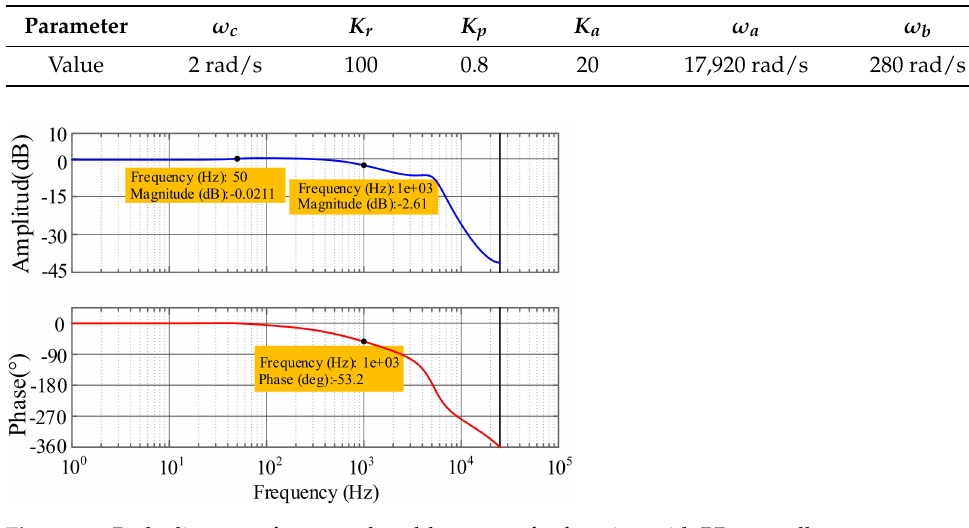
Figure 12. Bode diagram of system closed-loop transfer function with PR